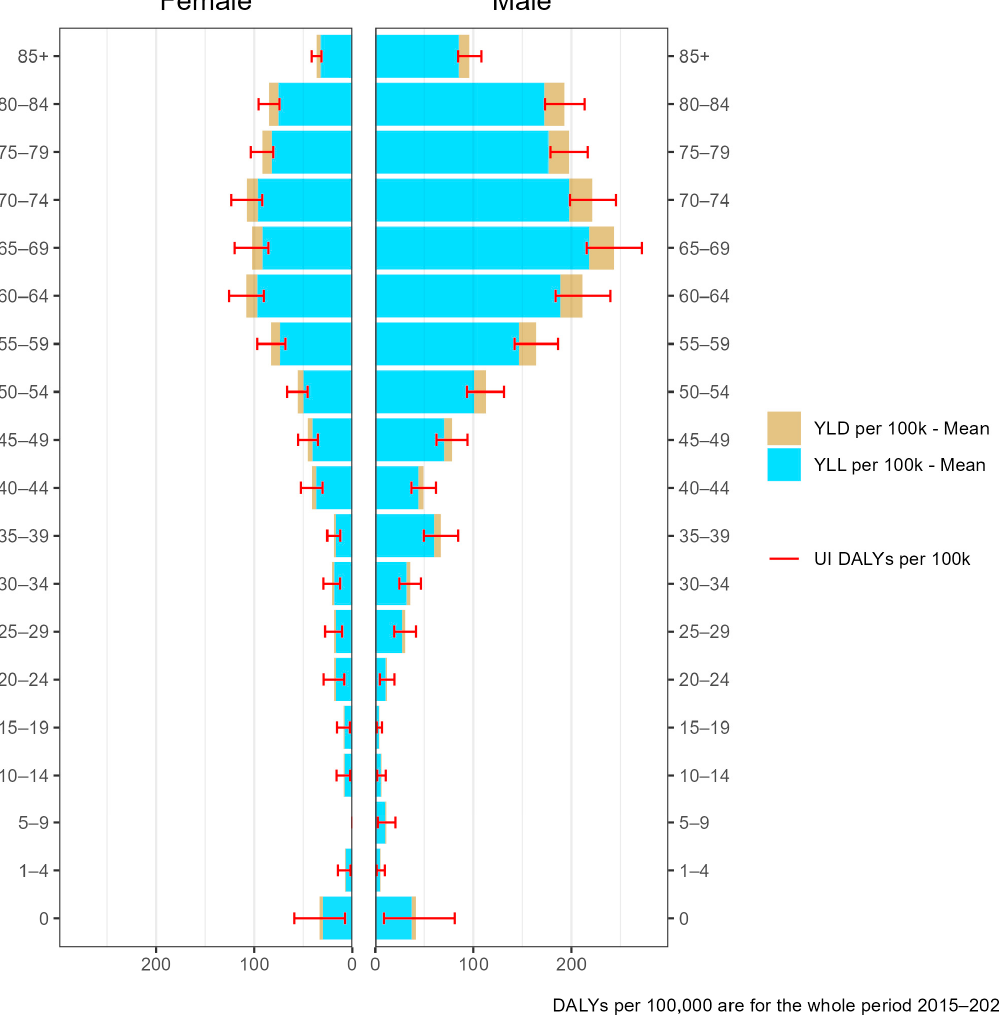
Figure 3. DALYs per 100,000 inhabitants stratified by age and sex for the whole study period in Germany (2015–2020). UI: Uncertainty Intervals; YLL: Years of life lost; YLD: Years lived with dis ‐ ease.